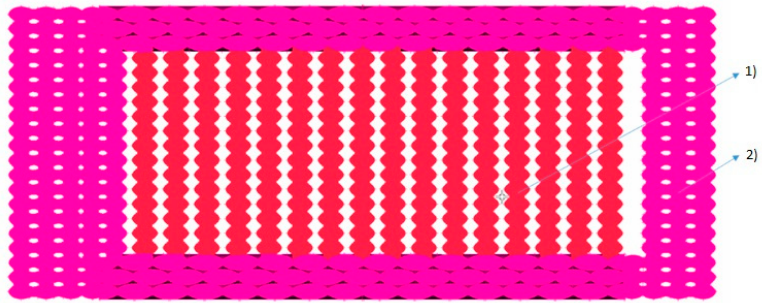
Figure 1. Infill section ( 1 ) and Shell section ( 2 ) of a printed ISO_5271A tensile specimen.